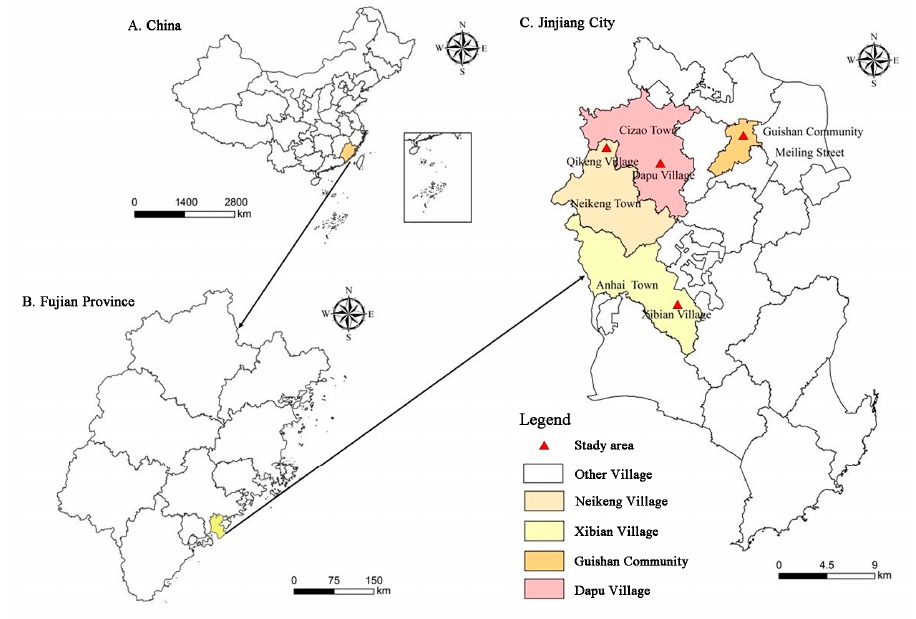
Figure 2. Map of study areas. Notes: Maps were collected from